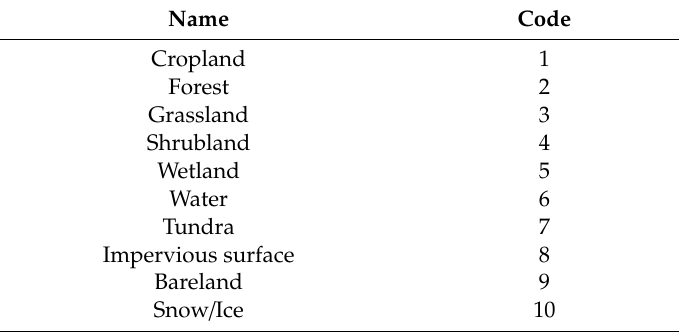
Figure 2. The overlay map of the Land cover classification and Shuttle Radar Topography Mission (SRTM) DEM data. Table 2. The classification system of